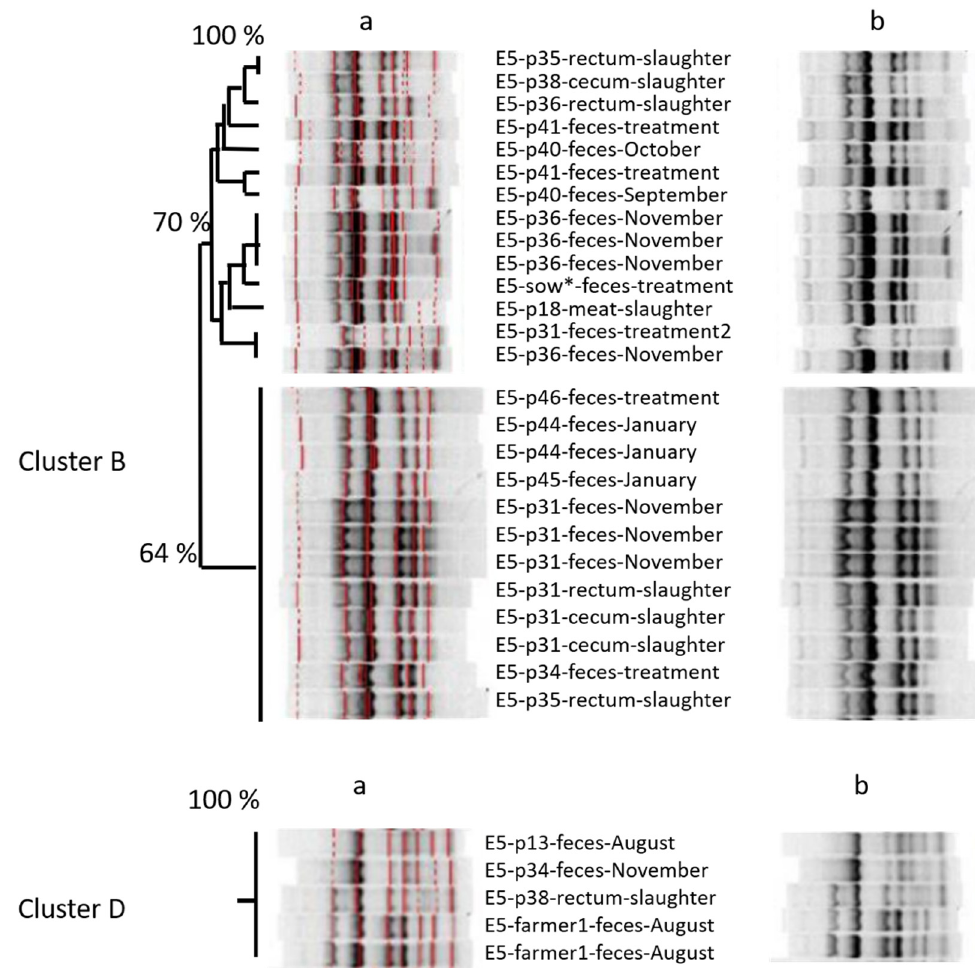
Figure 2. ERIC-amplicon-based cluster analysis of isolates from farm E5, taken at farm and at slaughter. Detail from the analysis showed 2766 isolates in total, with 1195 from farm E5. DNA- fragments were amplified by ERIC primers and visualized on 1% Agarose gel. All gels were aligned to standard bands: ( a ) software-based similarity assessment; ( b ) aligned, but unmarked bands for visual judgement. Numbers p13, p18: pigs tracked from May to August. Numbers p31, p34, p35, p36, p38, and p40: pigs tracked from August to November. Numbers p41, p44, p45, and p46: pig tracked from January to April. All treatments during the first month of tracking. All pigs slaughtered at the end of their tracking period. Sow: mother of p47 (pig fattened together with p41, p45, p44, and p46) during the first treatment days of p47. Cluster B, D: separate clusters with less than 50% similarity.